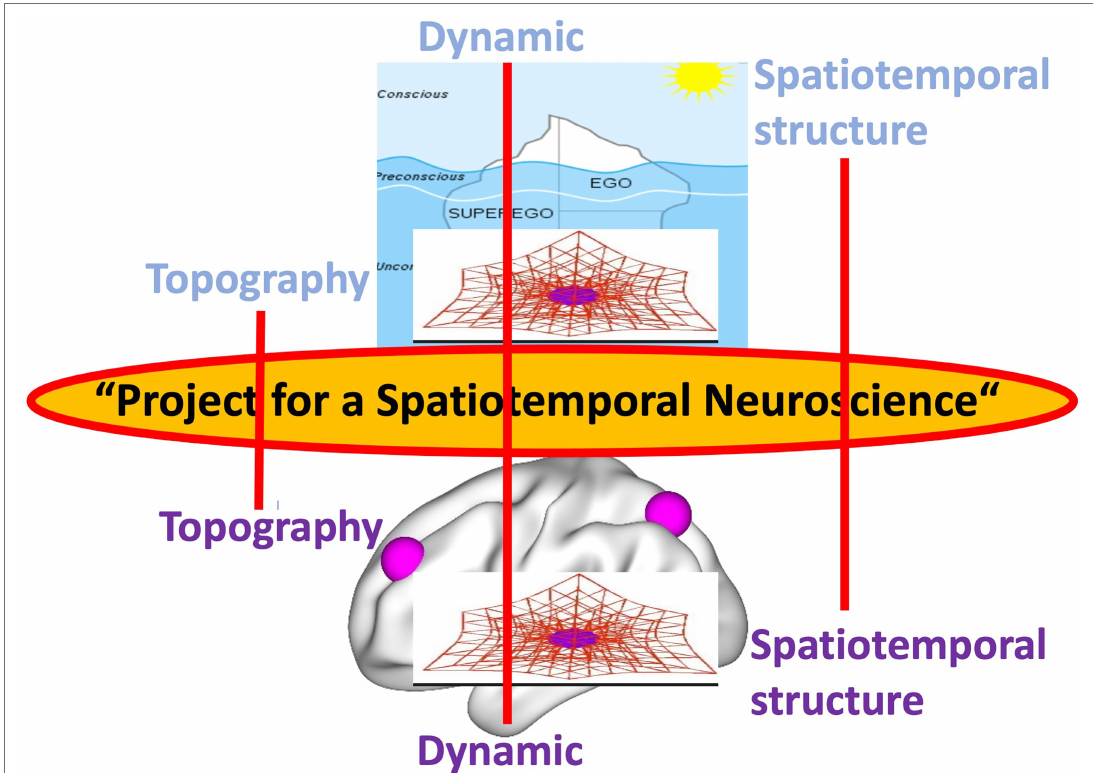
FIGURE 9 | Shared features as “common currency” (middle) of brain and (lower) and psyche